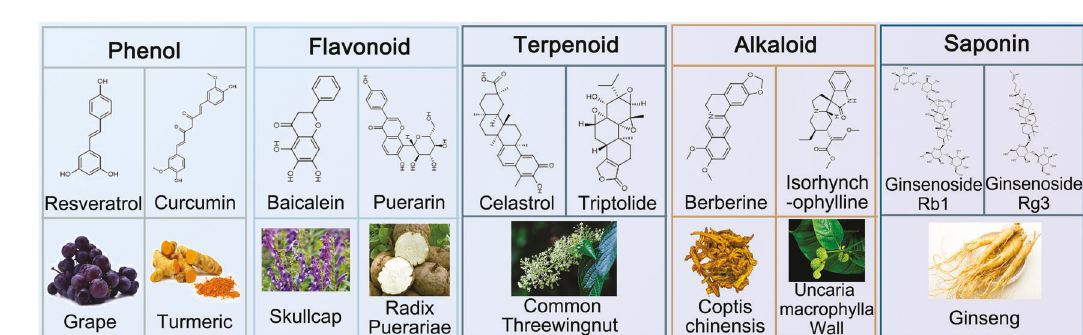
Fig. 5 Natural compounds for PD treatment derived from traditional Chinese